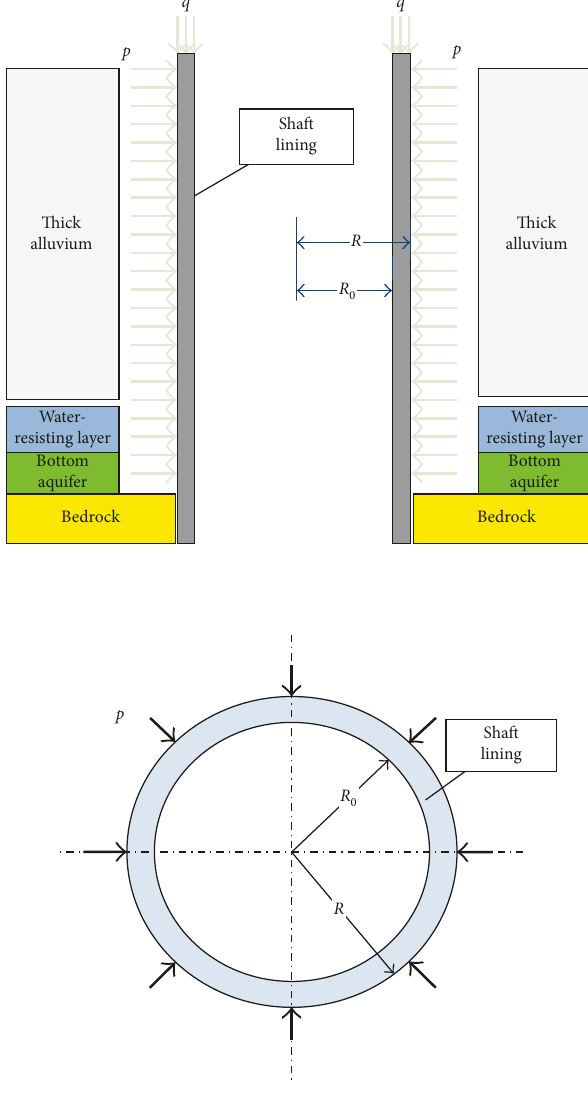
Figure 1: Mechanical model of the shaft